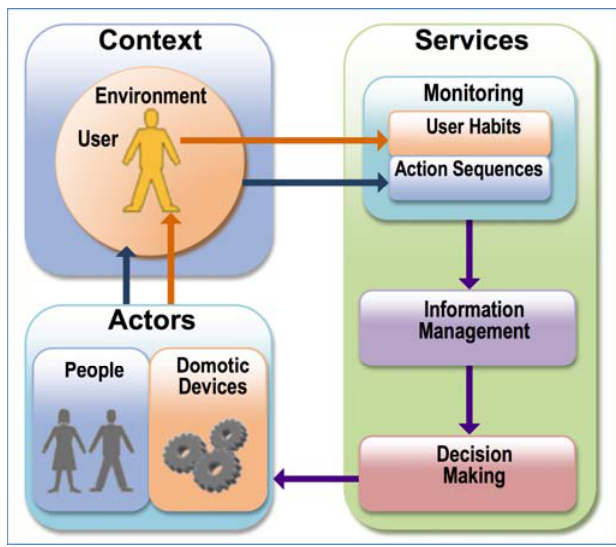
Figure 5. Scheme of AmI based